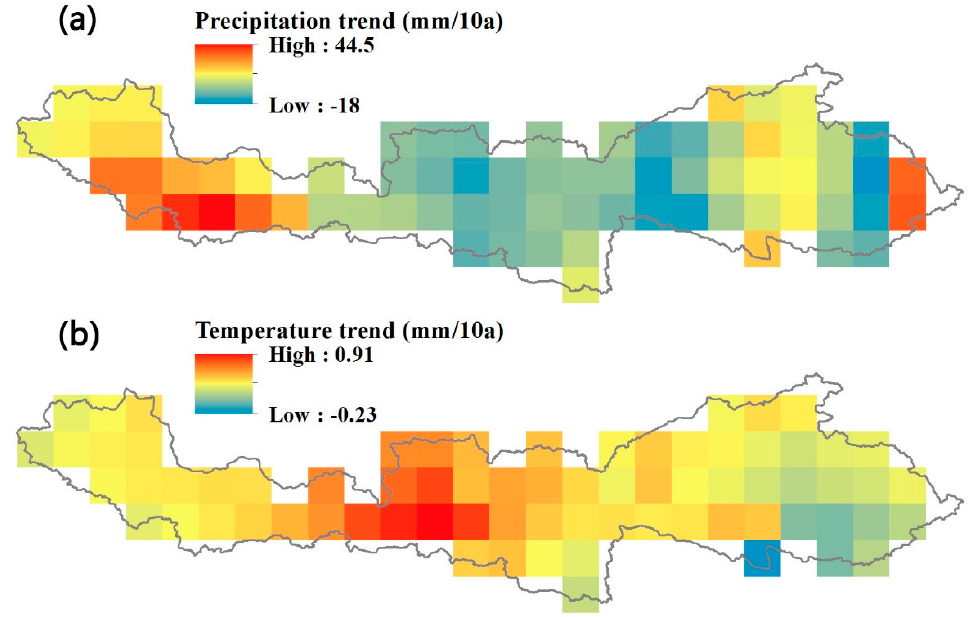
Figure 2. Linear trends in ( a ) annual precipitation and in ( b ) annual temperature at the grid level during the study period of 1961–2000